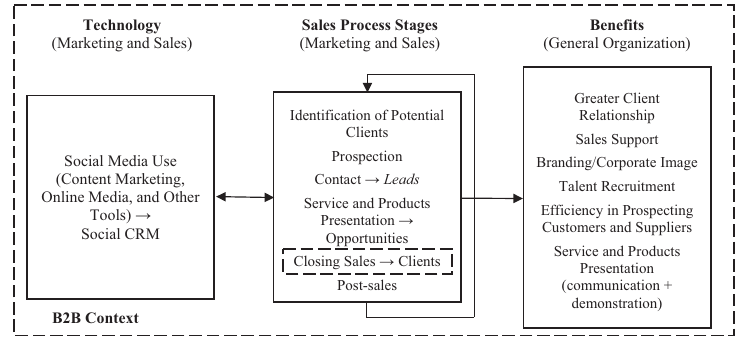
Figure 1. Meta causal